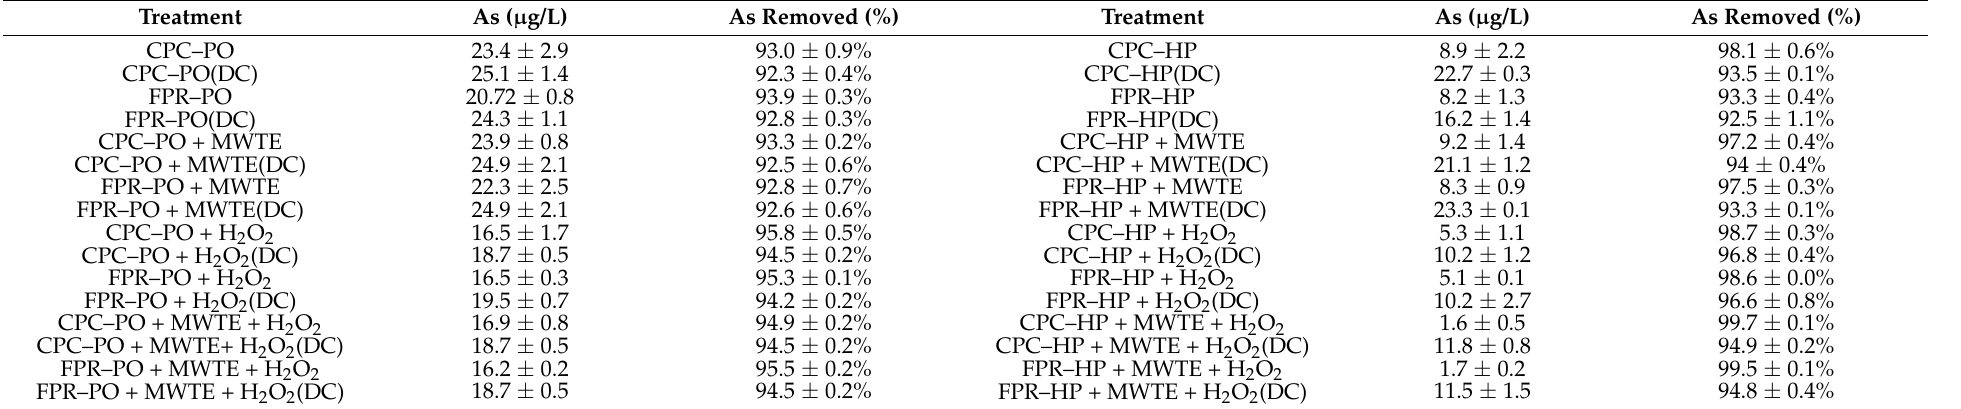
Table 4. Arsenic concentration after chemical precipitation with FeCl 3 .